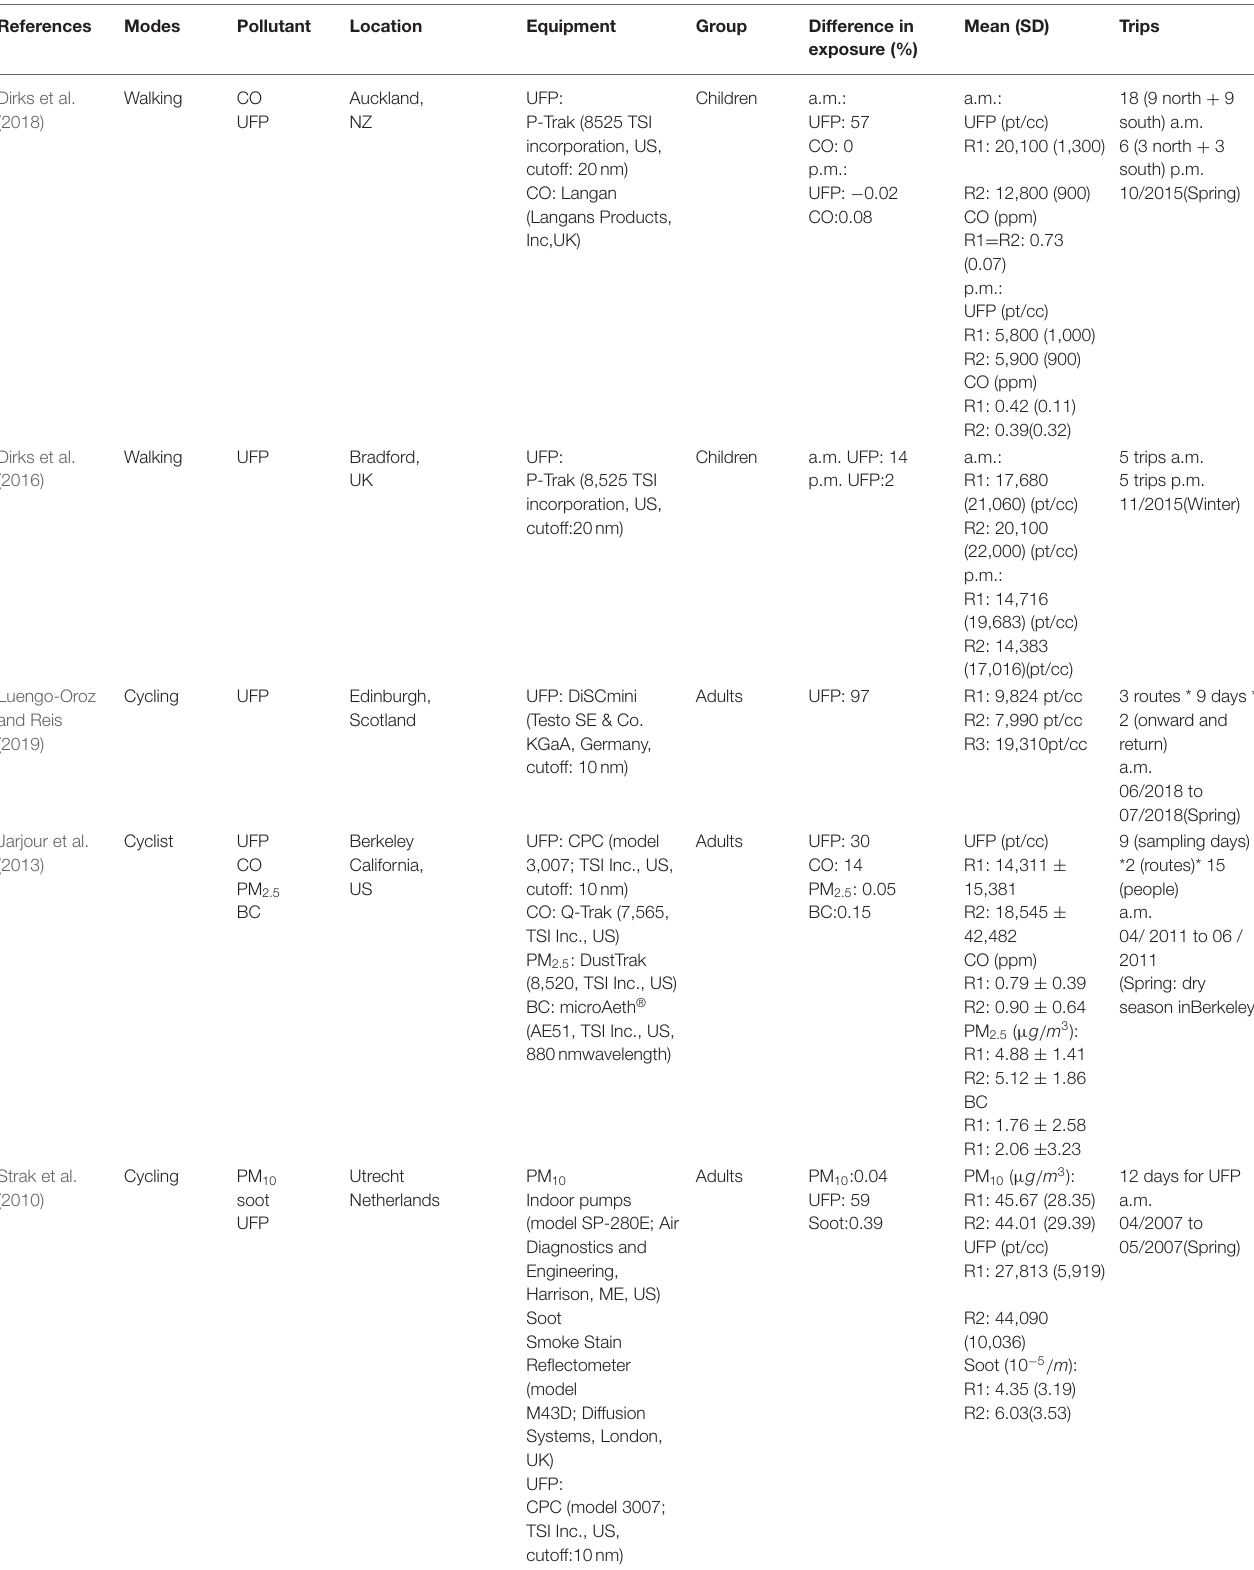
TABLE 1 | Main characteristics of the studies included in the systematic review (Int = interval, Pop den = Population density, cutoff: the threshold for the size of